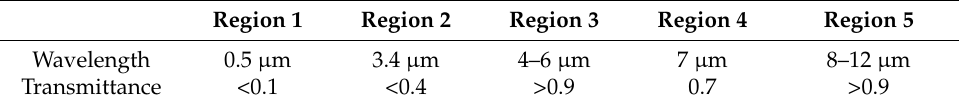
Table 1. FTIR transmittances for different spectrum regions of the crude oil